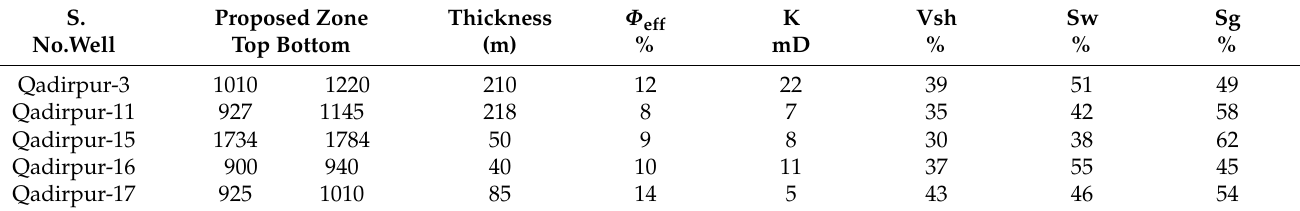
Figure 14. Water saturation (Sw) variation map computed in (%).